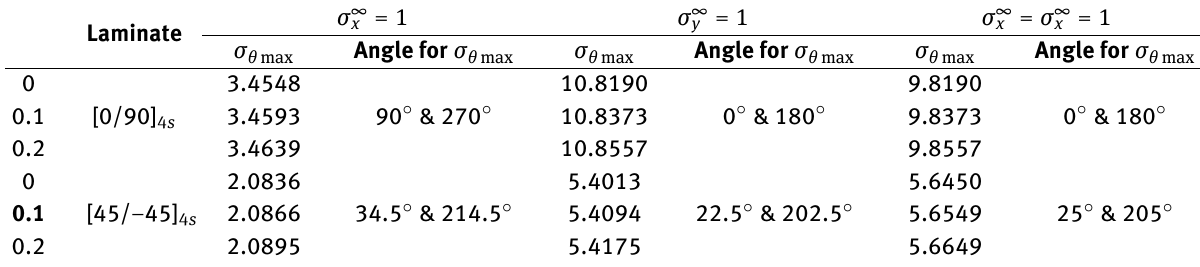
Table 6: Effect of moisture content on σ θ max